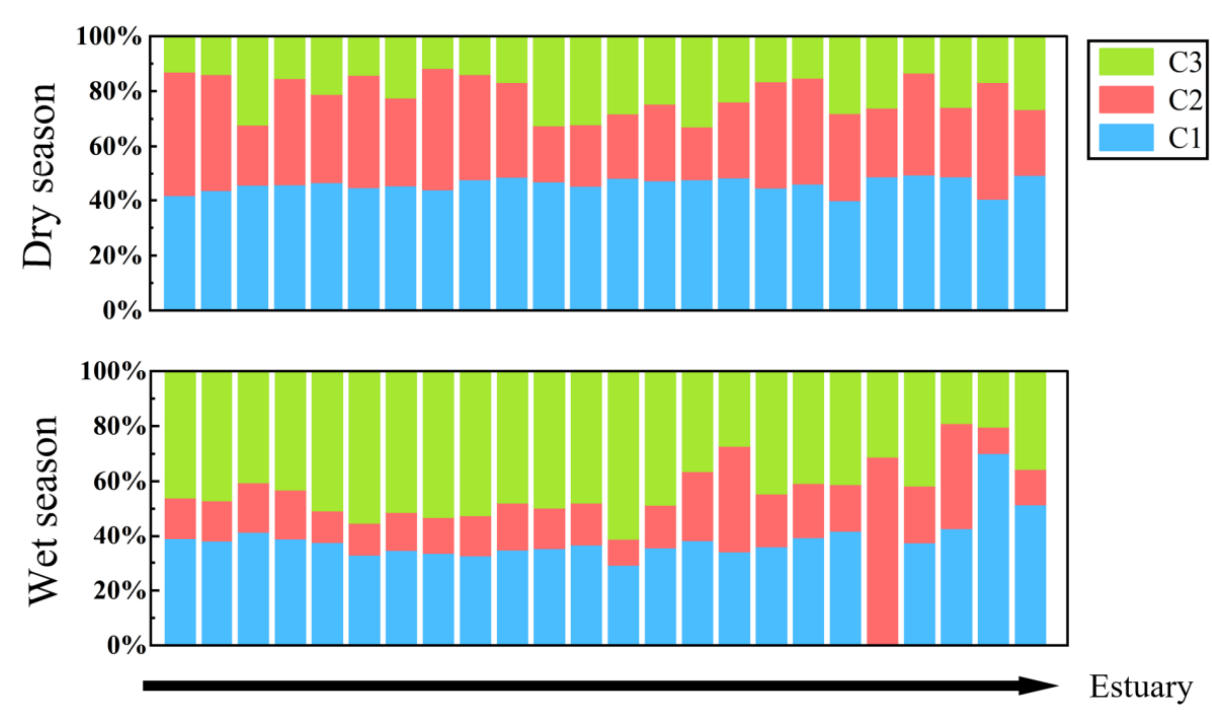
Figure 6. Relative ratios of fluorescence components of DOM in the Wanggang River.